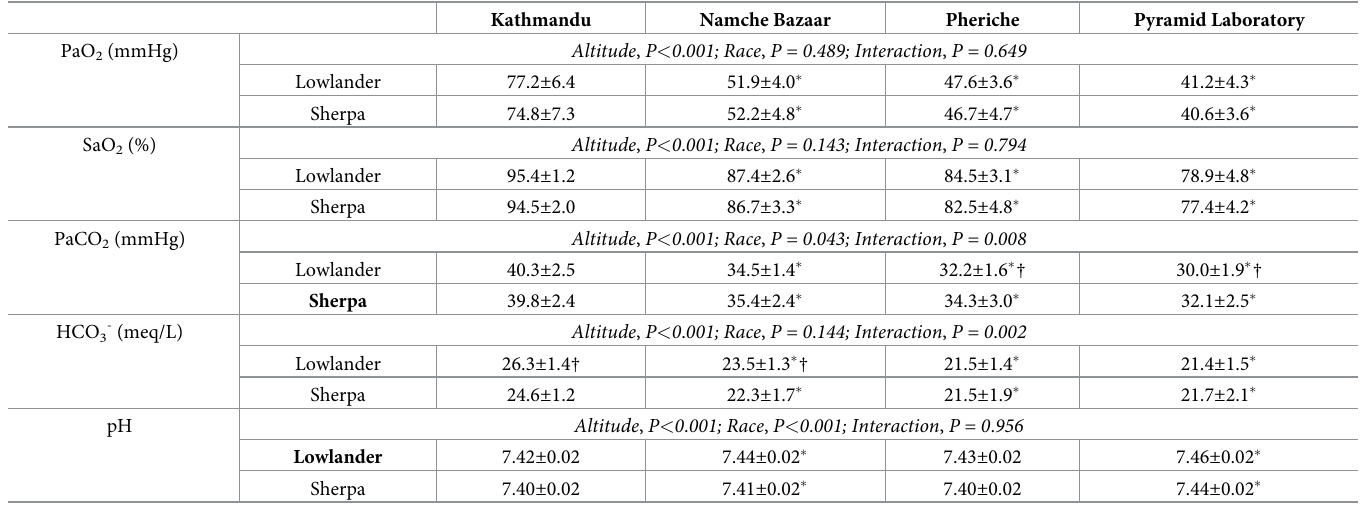
Table 4. Arterial blood gas data throughout ascent.